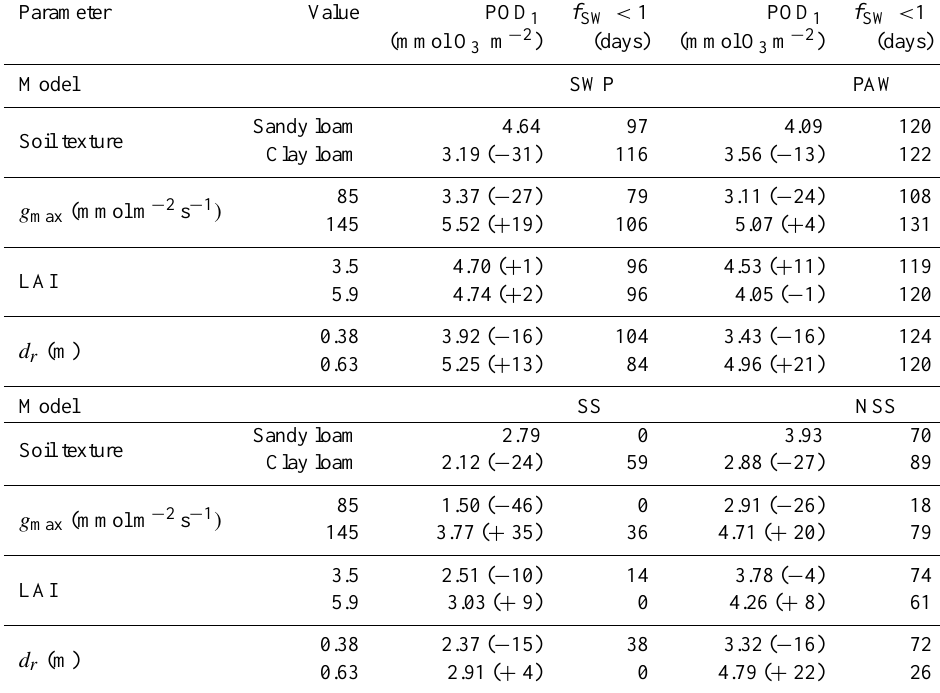
Table 7. Effects on changing parameters soil texture, g max , LAI and root depth ( d r ) on POD 1 and number of days with f SW < 1,